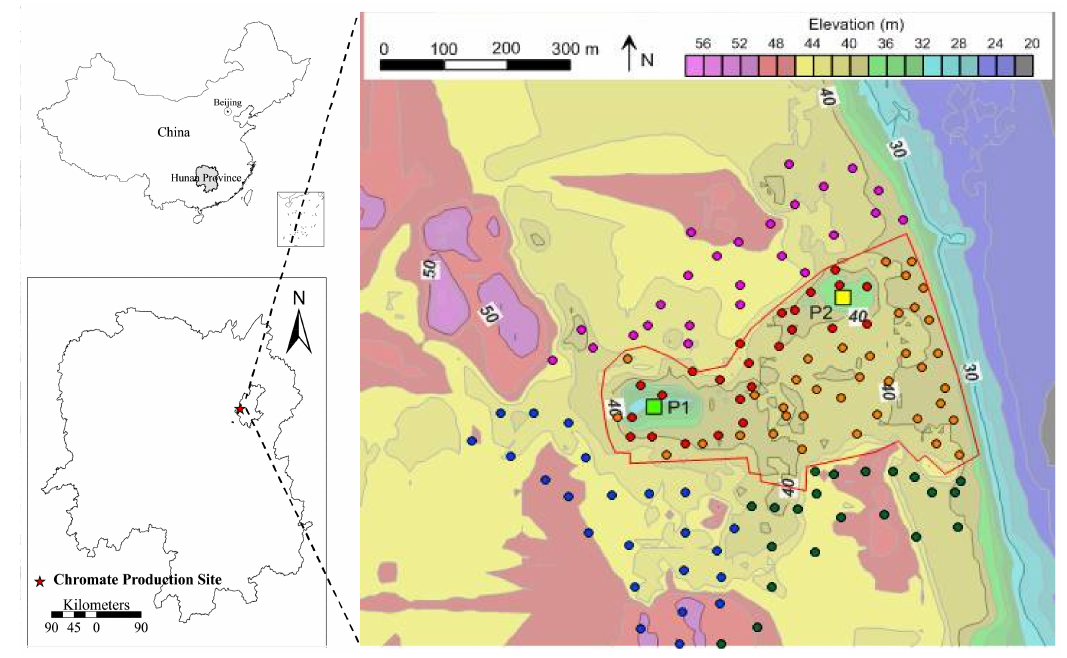
Figure 1. Location of the CPS. Red Line: boundary of the chromate production sites; Red Dots: soil profiles of the chromite ore processing residues (COPR) Storage Area; Orange Dots: soil profiles in the Production Plant Area; Pink Dots: soil profiles in the Xiangyue Chemical Plant; Green Dots: soil profiles in the Residential District; Blue Dots: soil profiles in the Changsha Zinc Plant; Square: remaining slag pits after dealing with COPR. The green and yellow squares were designated as P1 and P2,